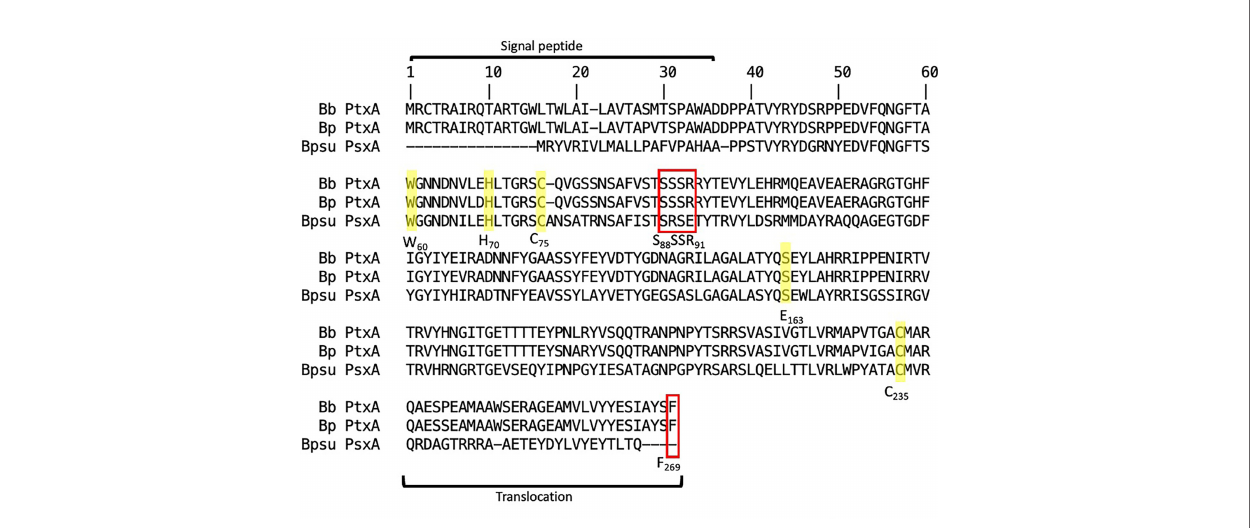
FIGURE 3 | Sequence alignment between Ptx-like toxins of B . pertussis (Bp), B . bronchiseptica ( Bb ), and B . pseudohinzii ( Bpsu ). ADP-ribosyltransferase catalytic sites are notated as